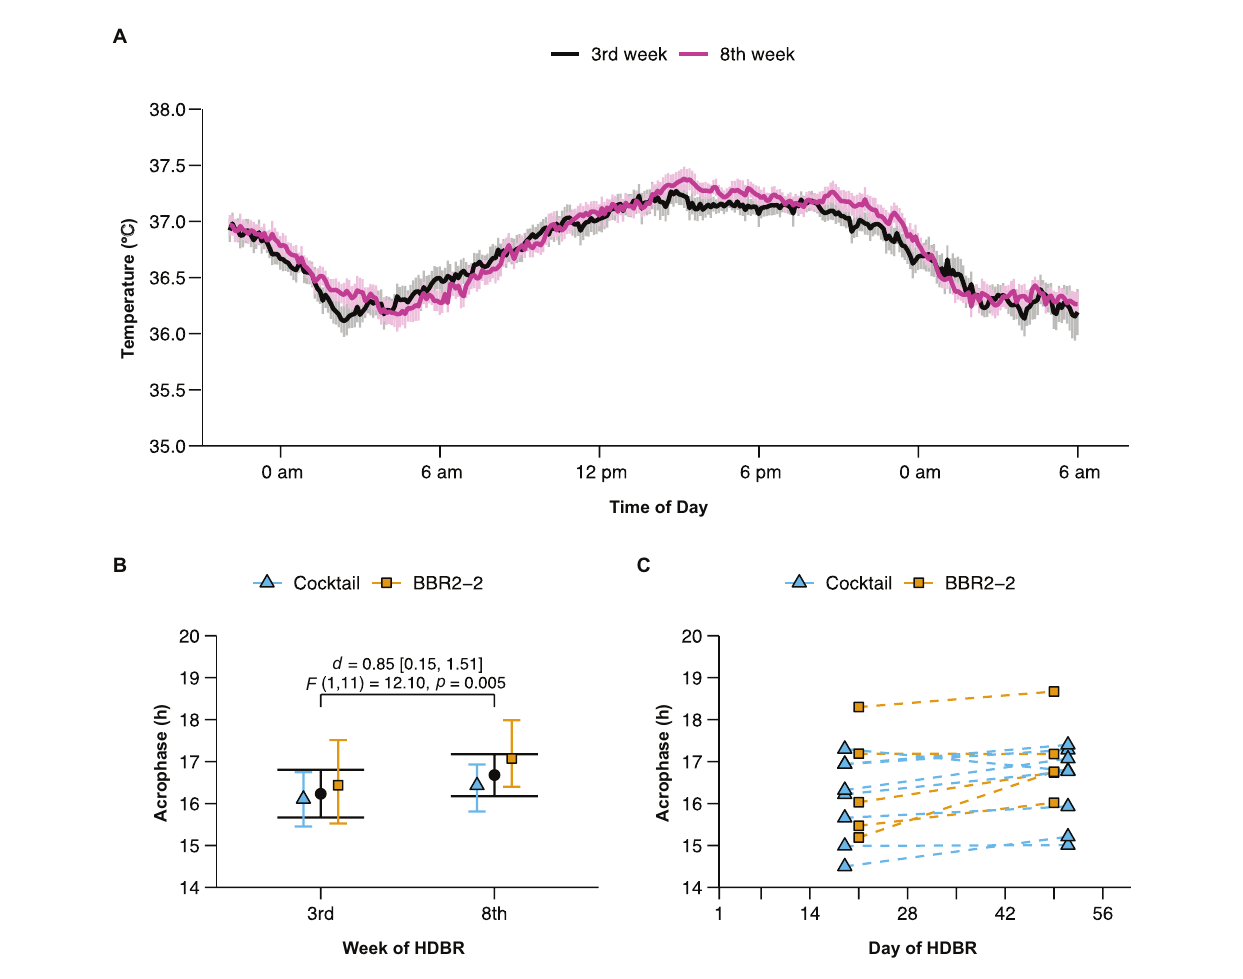
FIGURE 1 | Changes in the circadian rhythm of CBT during head-down tilt bed rest (HDBR; n = 13 participants). (A) Average CBT profile in the 3rd week (black) and the 8th week (purple) of HDBR. Vertical bars denote SE s. (B) Mean phase and 95% CI are shown in black and for each study site in blue ( Cocktail , n = 8) and yellow ( BBR2-2 , n = 5). (C) Changes in rhythm phase for each individual (dashed lines) during bed rest.